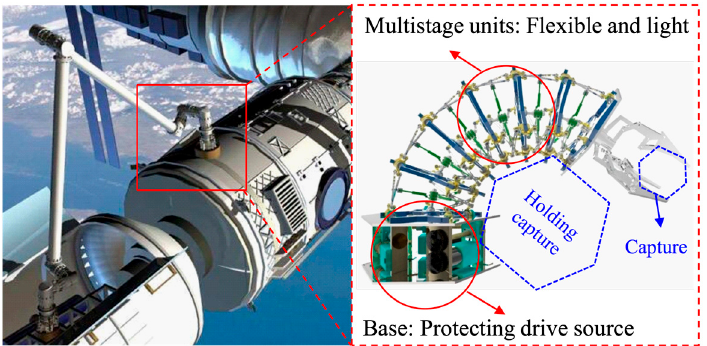
Figure 1. Schematic diagram of space continuous robot and capture mode.